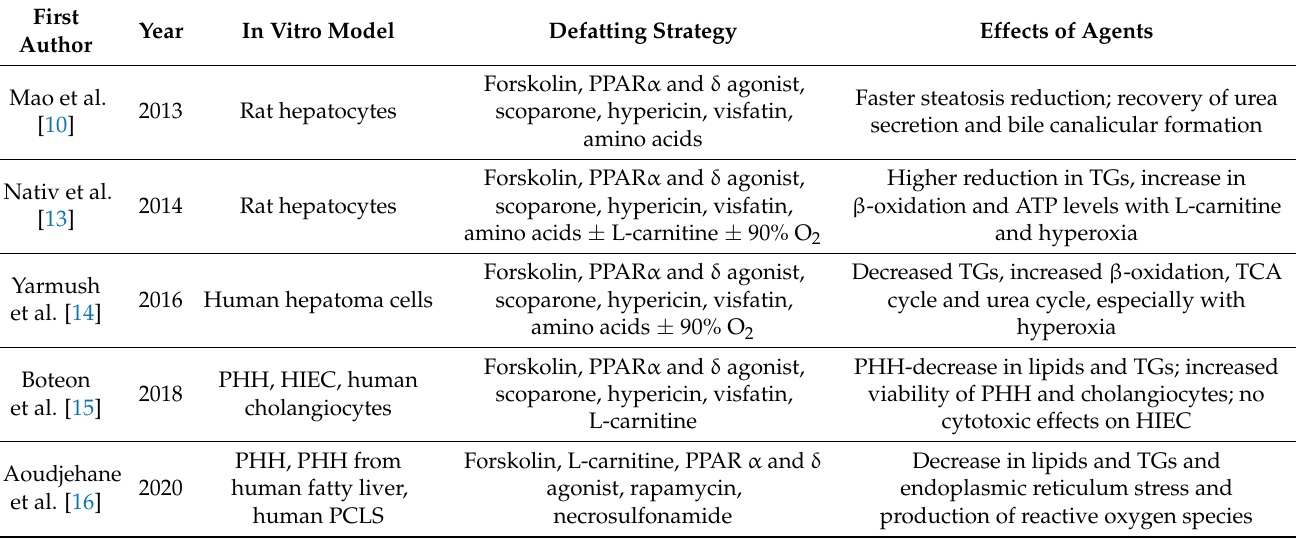
Table 1. Summary of In Vitro Defatting